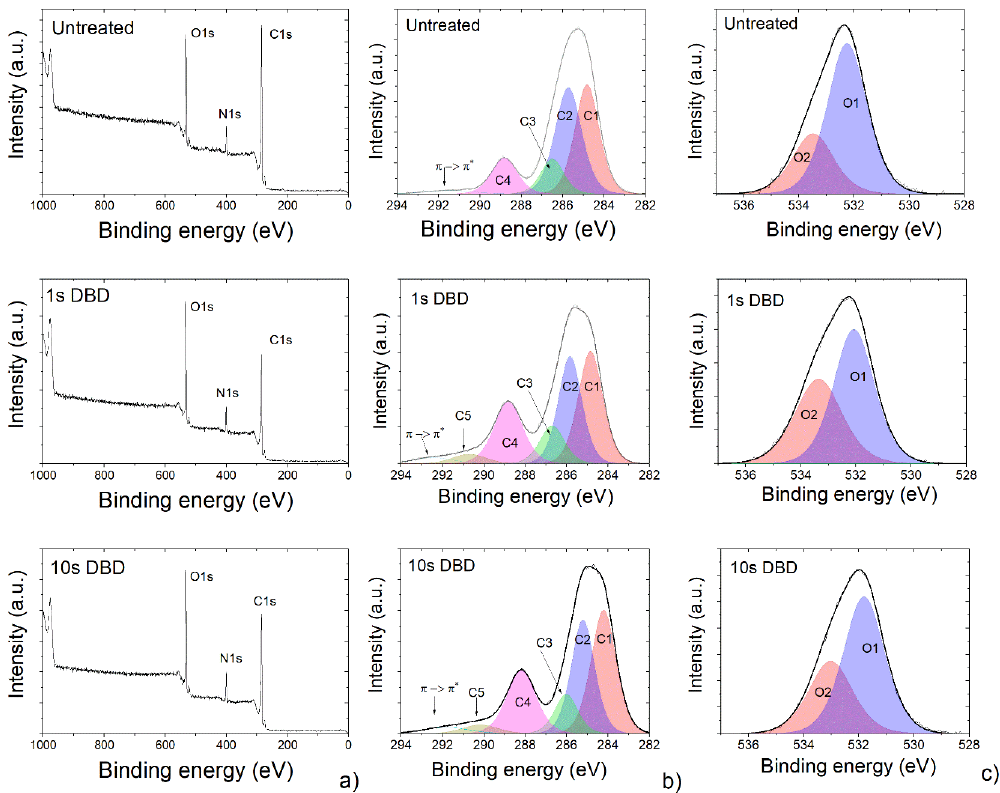
Figure 2. ( a ) Survey XPS spectra and high-resolution XPS spectra of ( b ) C 1s peak and ( c ) O 1s peak. Panels show XPS of untreated Kapton (top), XPS spectra after 1 s of DBD treatment (middle) and XPS spectra after 10 s of DBD treatment (bottom).